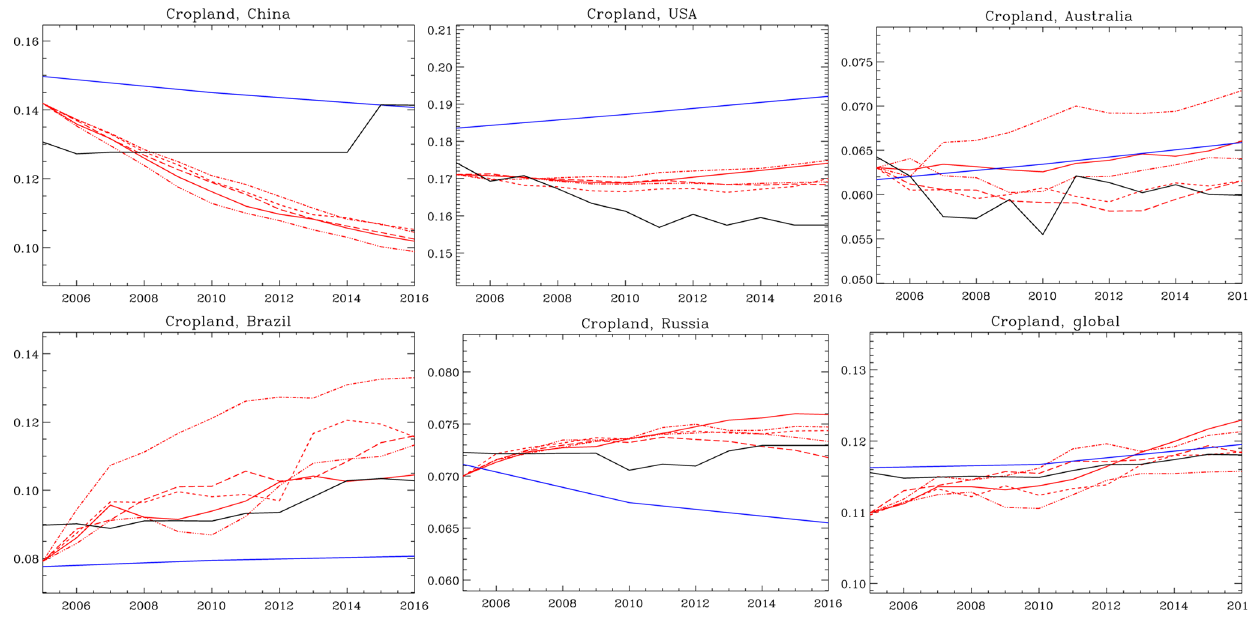
Figure 7. Comparison of historical cropland area simulated by MIROC-INTEG-LAND (red), AIM/CGE (blue), and FAOSTAT (black), using the ratio of cropland area to total area. For MIROC-INTEG-LAND simulations, the cropland area results for the five different climate forcings are shown.